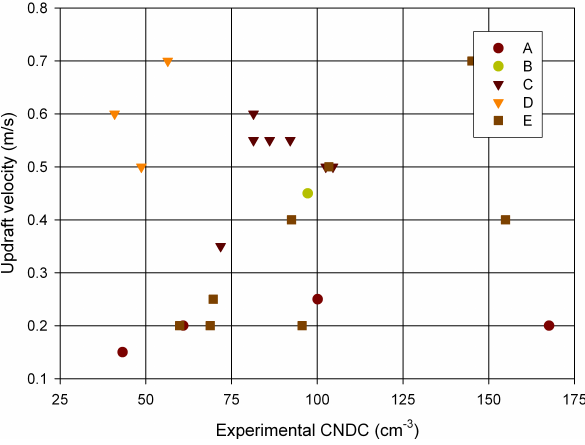
Fig. 9. Cloud droplet number concentrations versus the model based estimates for the updraft velocity.